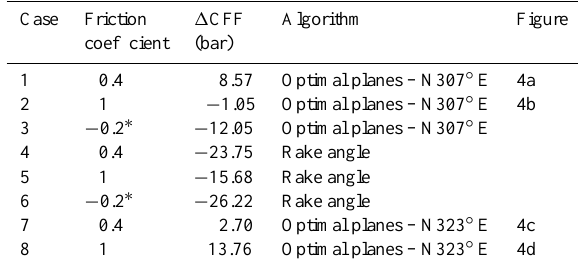
Values of Coulomb stress at the 1990 hypocentre (45.87 ◦ N, 26.87 ◦ E, 89km) for optimally oriented planes to re- gional compression (cases 1 to 3) and for 1990-type target planes (cases 4 to 6), respectively. Cases 7 and 8 show 1 CFF values as- suming a regional compression azimuth of N323 ◦